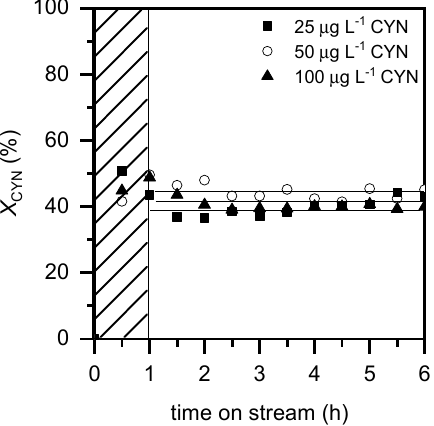
Figure 4. Effect of H 2 O 2 dose on the removal of CYN upon CWPO (flow rate = 0.2 mL min − 1 , [CYN] 0 = 25 μ g L − 1 , W Fe3O4 = 14 g, pH 0 = 5, T = 25 °C).